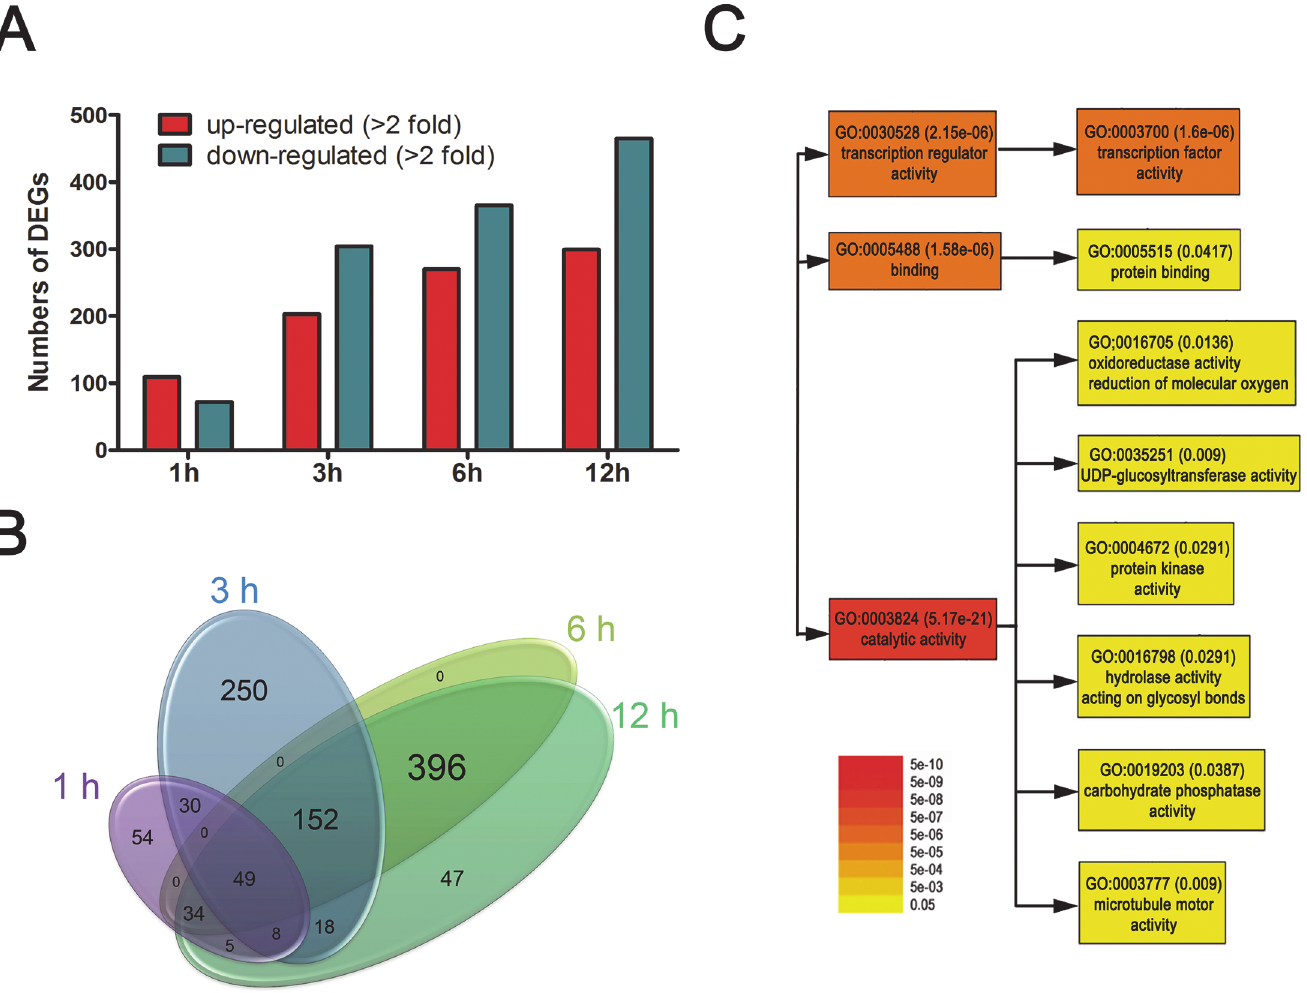
Fig 3. Summary of microarray analysis of cotton ovules cultured with phytohormones. A. Comparison of up- or down-regulated DEGs in cultured cotton ovules (-1 DPA) that were treated for 1, 3, 6, and 12 hours with IAA + GA. B. Venn diagrams representing the common and specific DEGs among the four time points in cultured cotton ovules (-1 DPA). C. GO enrichment analysis. Singular enrichment analysis was used to identify GO categories potentially governing differential expression of genes involved in fiber initiation caused by exogenous phytohormone treatment. The color and numbers adjacent to the GO identifier represent